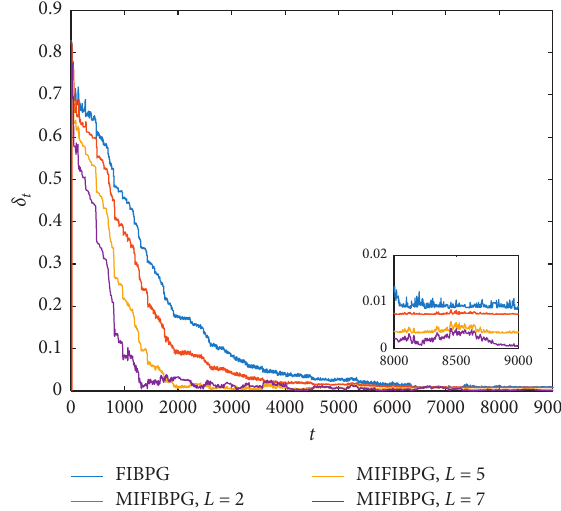
Figure 12: Evolution curves of parametric error for the FSOEAHW model using MIFIBPG